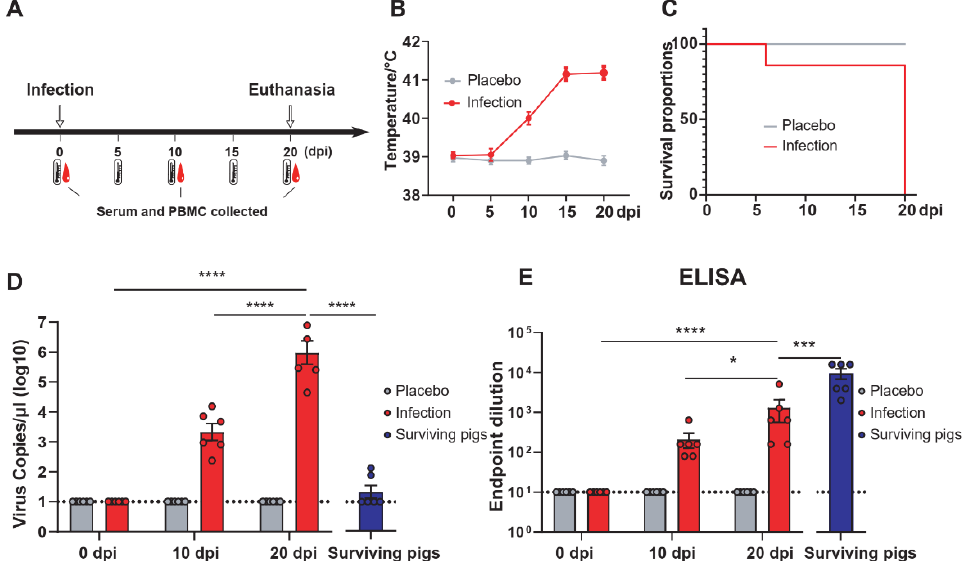
Figure 4. Clinical trials and humoral immunity levels of ASFV-infected pigs and the comparison with surviving pigs. ( A ) Procedures for ASFV infection in pigs. In the infected group, a pig (a#) was infected with ASFV by intramuscular injection and cohabitated with other pigs (b# to g#). In the placebo group, a pig (h#) was intramuscularly injected with PBS and cohabitated with other pigs (i# to n#). The PBMCs and serum samples of surviving pigs (Pig 2#, Pig 3#, Pig 5#, Pig 7#, Pig 10#, and Pig 14#) were selected as convalescent pigs. Rectal temperature monitoring and blood collection was performed at the indicated time points (dpi) after infection. ( B ) Trend of rectal temperature at different time points in ASFV-infected pigs. ( C ) Survival curves of pigs challenged with ASFV (1 artificial infection and the other six contact infection pigs) or PBS (one intramuscularly injected with PBS and the other 6 contact-infected pigs) ( D ) Blood viral load of ASFV-infected pigs at different time points. ( E ) Titers of anti-p72, -pp62, and -p30 specific IgG in pigs infected with ASFV. The dotted horizontal lines represent the quantitative limits of ELISA and viral RNA load. The data are shown as the mean ± SEM. p- values were determined by one-way ANOVA (* p < 0.05; *** p < 0.001; and **** p < 0.0001).